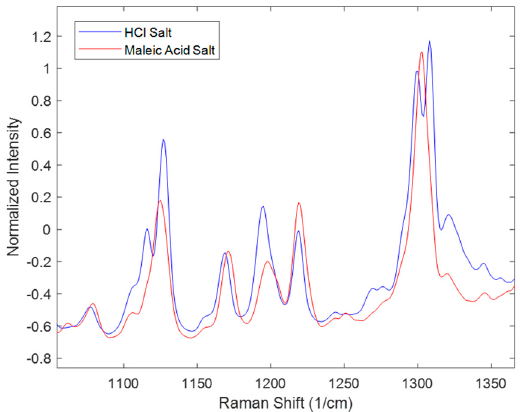
Figure 4. Raman spectra of the completed disproportionation process for HCl salt and maleate salt of the 16.7 mg/mL test run condition.